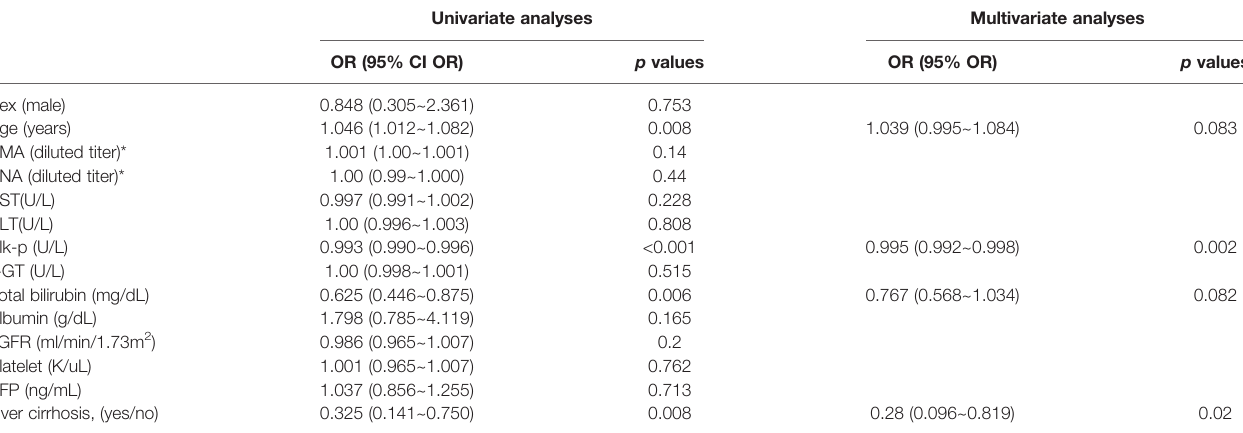
TABLE 2 | Baseline factors associated with UDCA response.